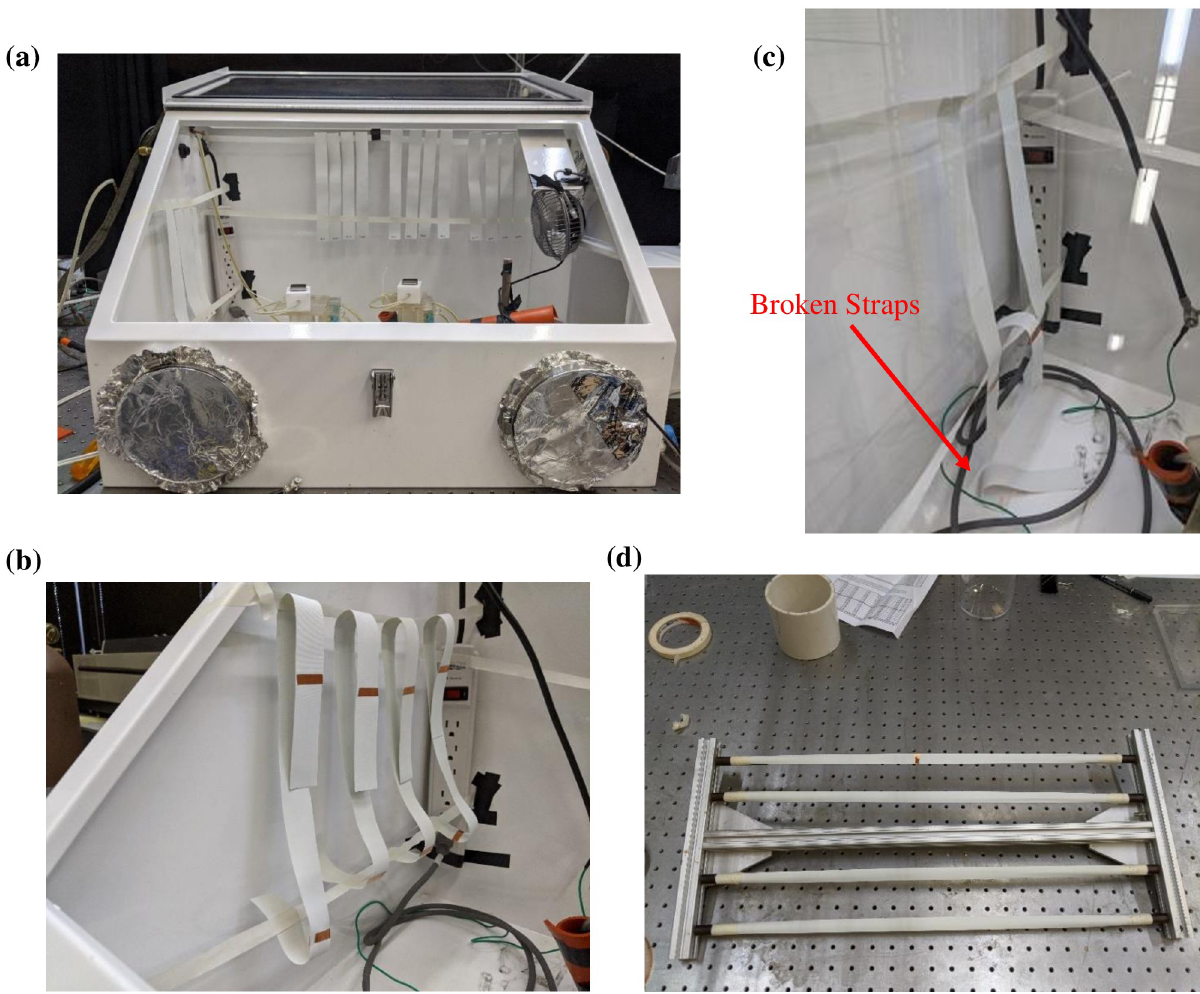
Fig 24. Strap (polyisoprene) arrangement in glovebox testing: (a) straps placed without any stress, (b) straps placed with a stress, (c) broken strap after treated by 1000 ppm-min dose, and (d) straps elongated to double their initial